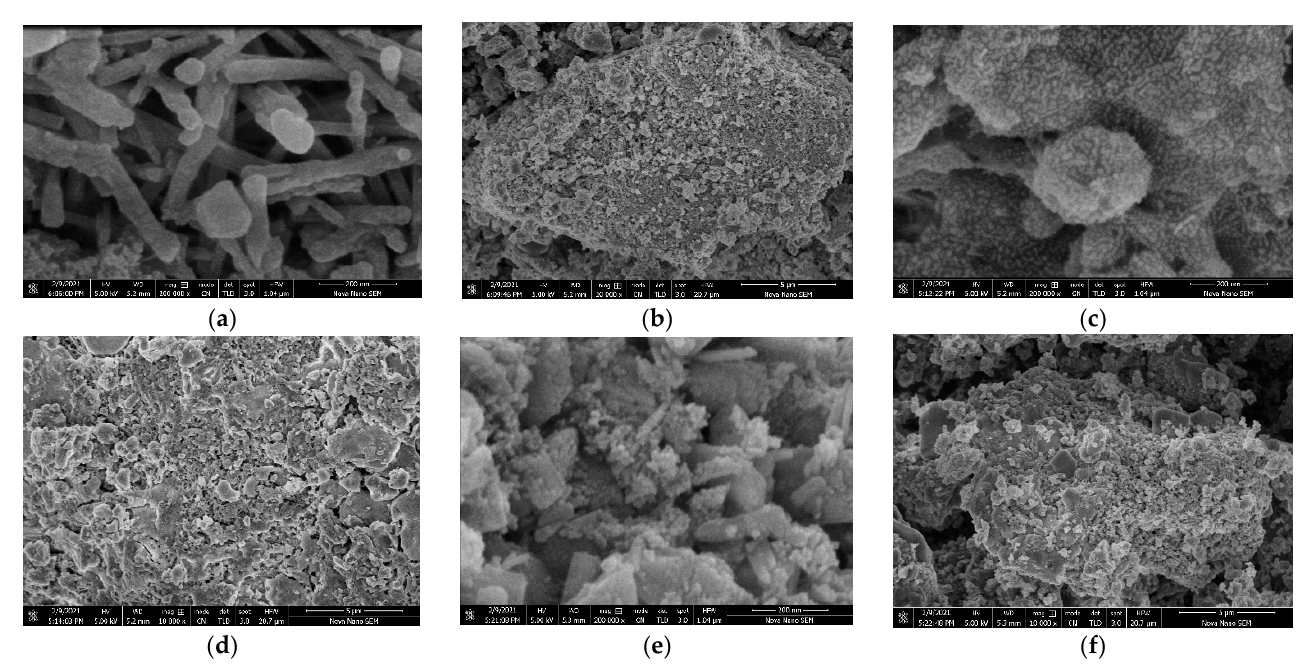
Figure 6. SEM images of prepared nano-catalysts of ICdO at different magnification. ( a ) SEM image of pure ICdO taken at 200 nm, ( b ) SEM image pure ICdO taken at 5 µm, ( c ) SEM image taken acidic ICdO at 200 nm, ( d ) SEM image of acidic ICdO taken at 5 µm, ( e ) SEM image of basic ICdO taken at 200 nm and ( f ) SEM image of basic ICdO taken at 5 µm.